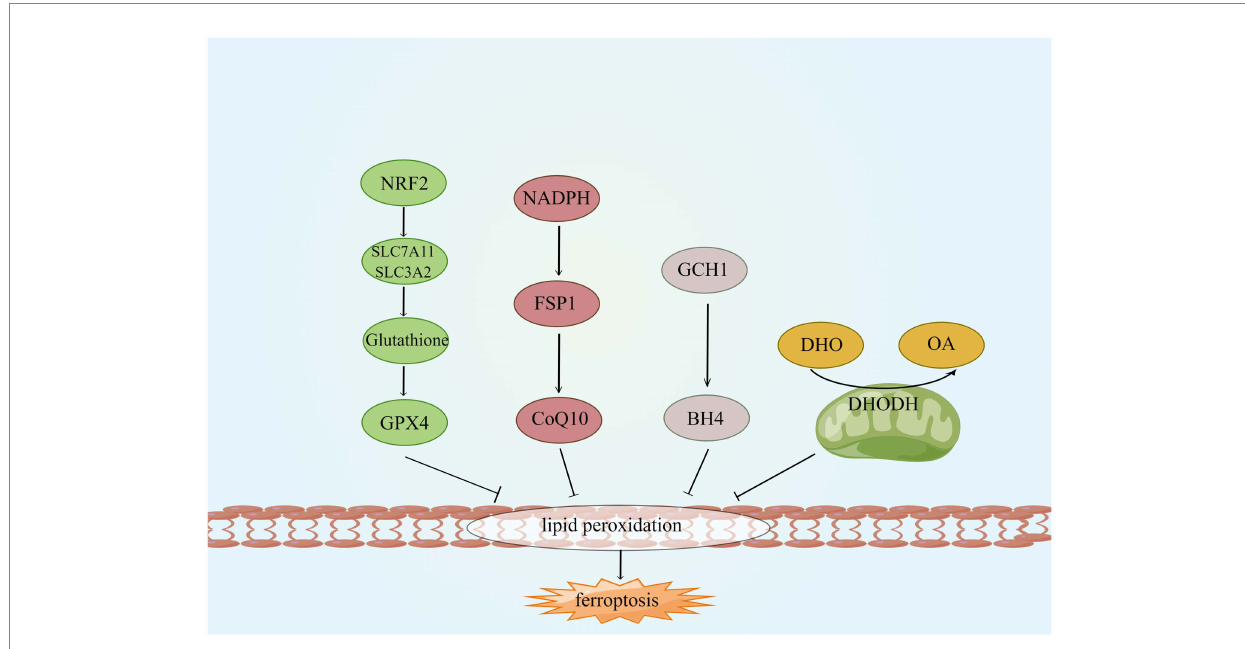
FIGURE 6 Four ferroptosis defense pathways. GCH1, GTP cyclohydrolyse-1; FSP1, ferroptosis suppressor protein 1; CoQ10, coenzyme Q; DHODH, dihydroorotate dehydrogenase; DHO, dihydroorotate; OA, orotate; GSH, glutathione; and BH4,